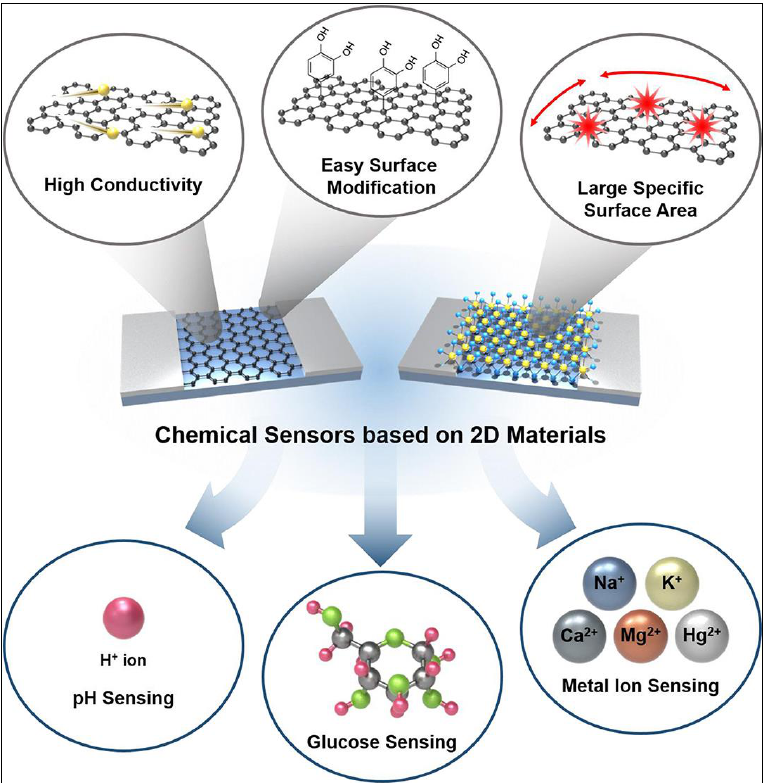
Figure 3. Schematic illustration of chemical sensors based on 2D materials with advantages of 2D materials and their application into ion/molecule sensing. Reprinted with permission from Ref. [41]. 2019, Lee, Suh and Jang.